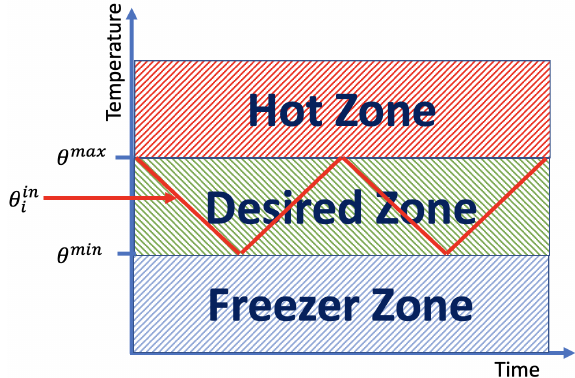
Figure 3. Indoor temperature